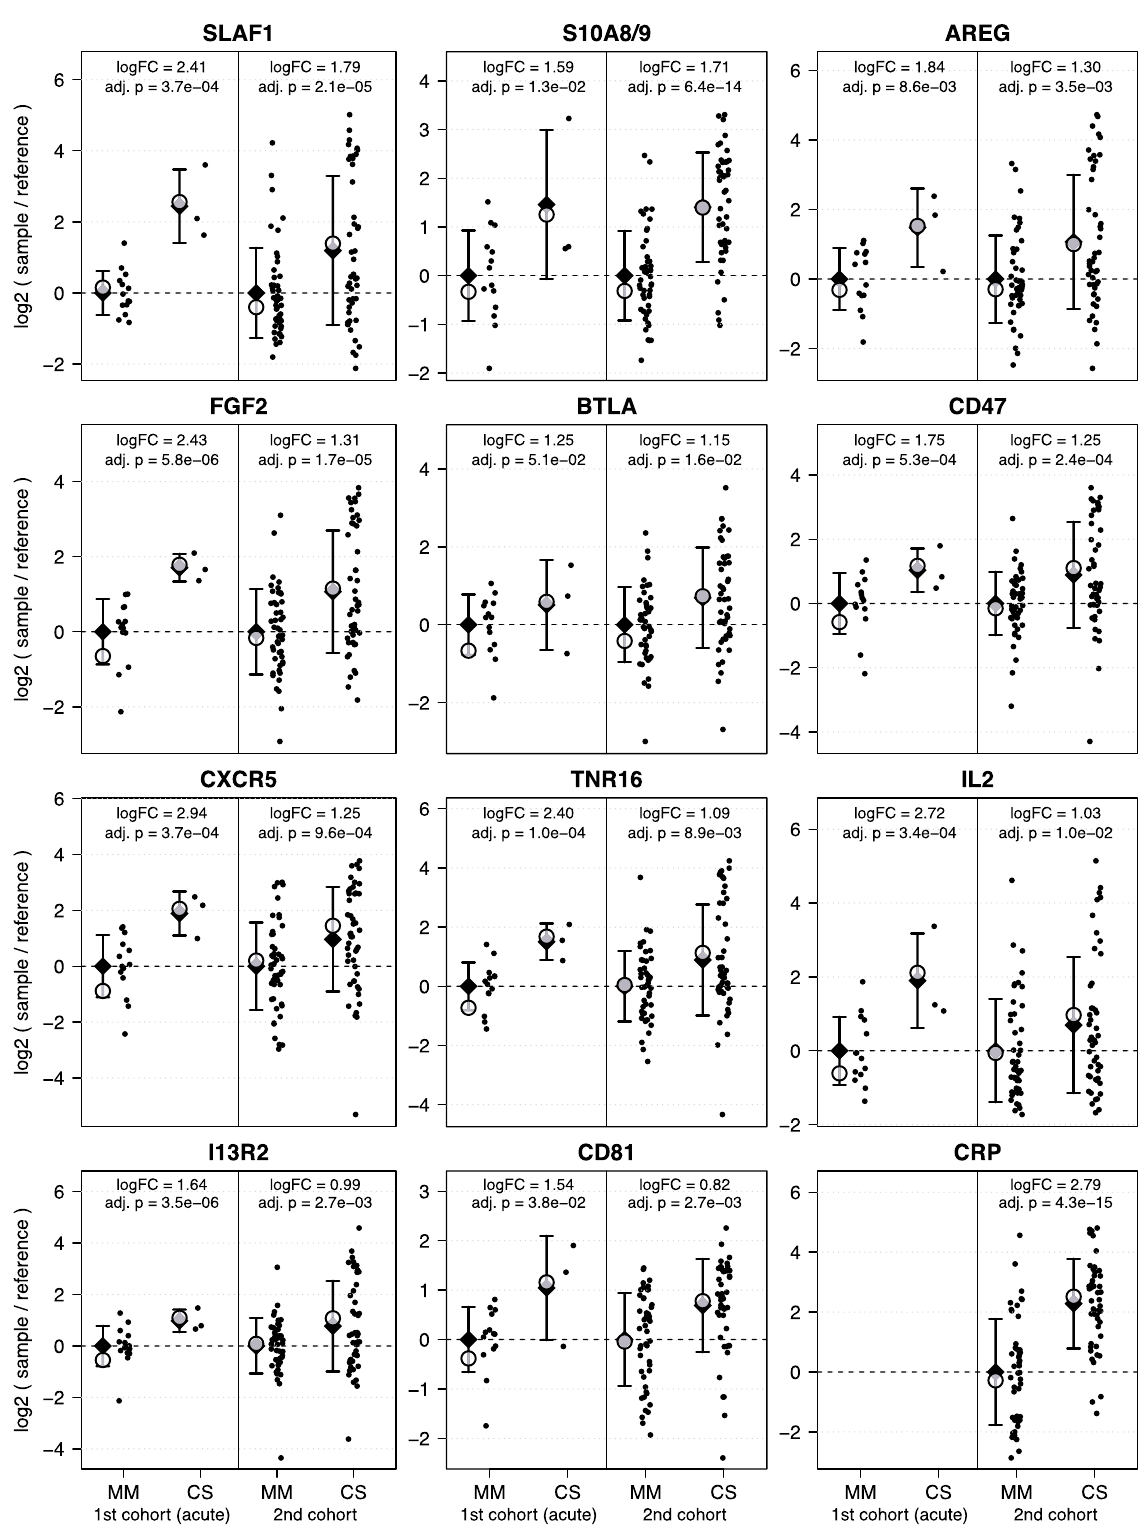
Fig. 5 Biomarkers to predict a severe / critical disease in both study cohorts. The y-axis illustrates log2(sample / reference) values after subtracting the group mean of the respective MM samples per cohort/protein, thus setting the mean value of MM samples as a baseline. Within the 1 st cohort 18 samples (MM = 17; CS = 3) were analyzed, while 94 sample (MM = 47; CS = 47) were analyzed within the 2 nd cohort. The x-axis is divided based on clinical course of disease of the patient (CS and MM). Only acute CS and MM samples are shown. Diamonds indicate arithmetic sample group means. Whiskers indicate one standard deviation, calculated based on the arithmetic means. Empty circles indicate the group coef fi cients fi tted by the linear model with additional factors sex, age and comorbidities, which were used for logFC and p value